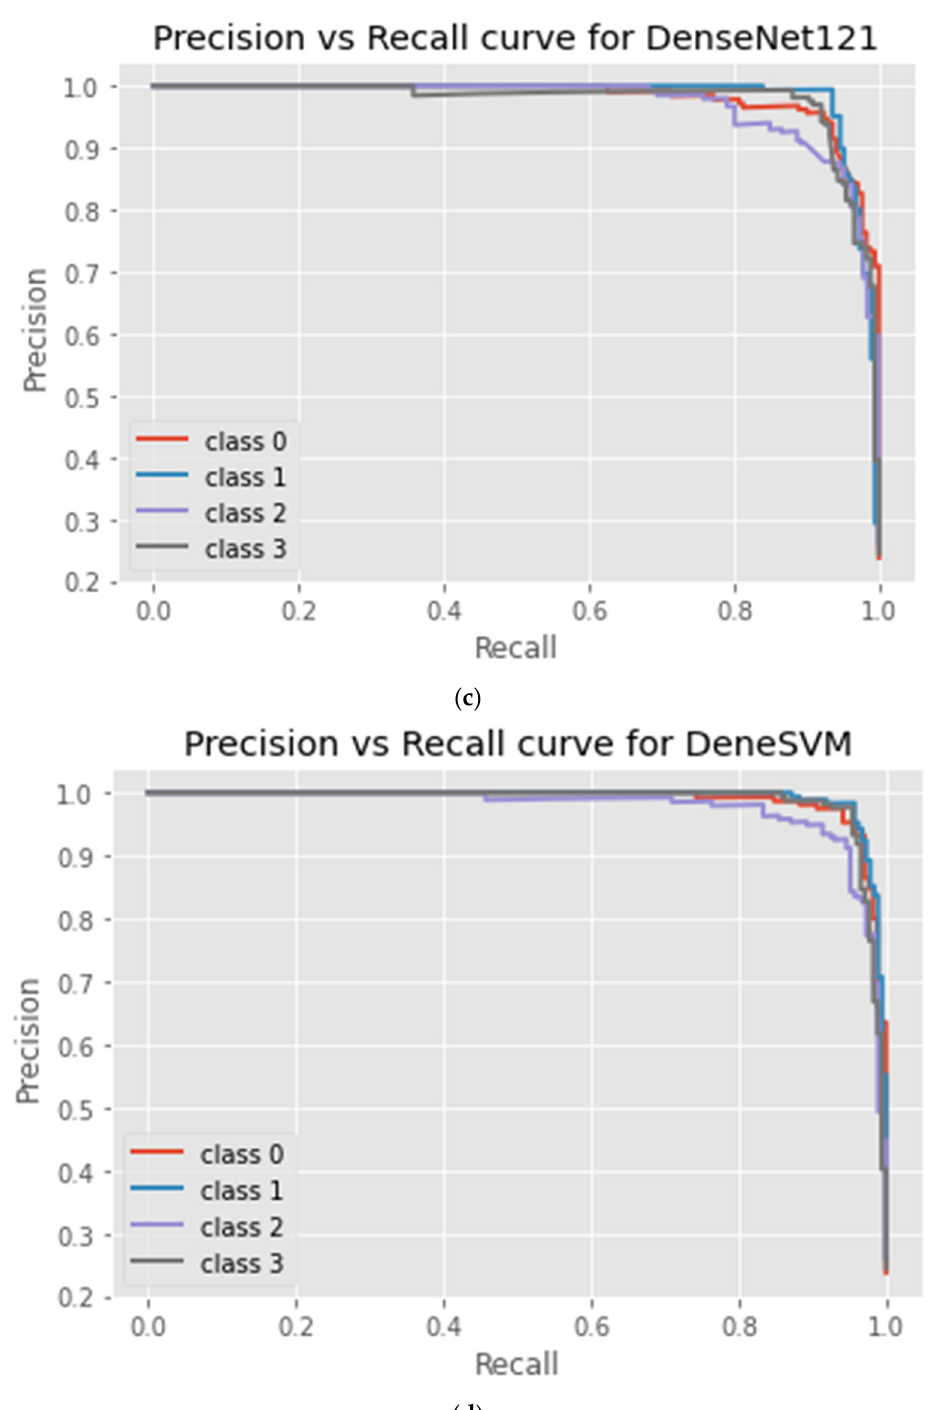
Figure 6. Precision_Recall curve of DTL models: ( a ) InceptionV3; ( b ) ResNet50V2; ( c ) DenseNet121; and ( d ) proposed DeneSVM .